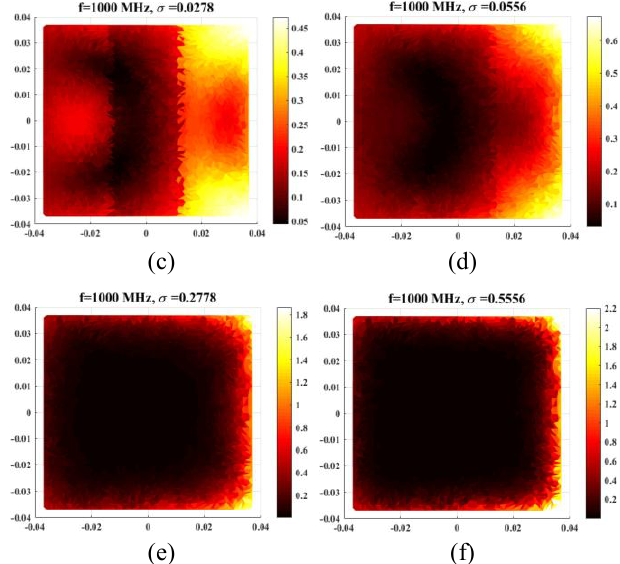
Figure 9: Distribution of fields in an inhomogeneous square scatterer illuminated by an incident field at –x direction with increasing 𝜎